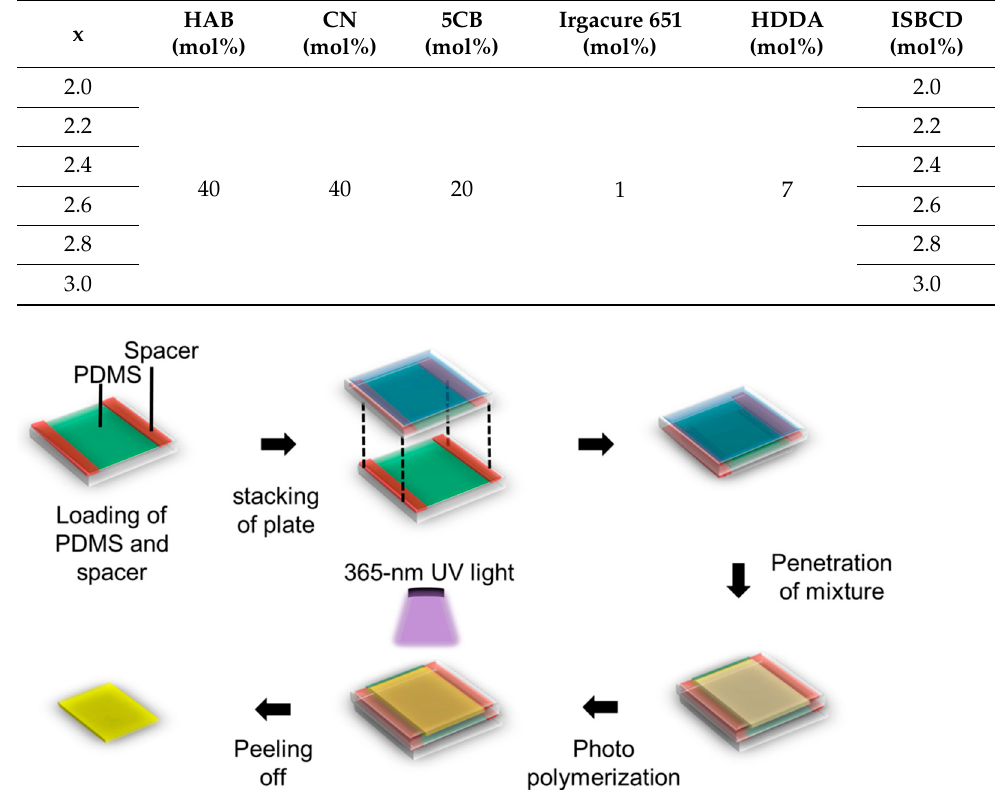
Table 1. Monomer mixtures for synthesizing N* LC ( x ) elastomers.